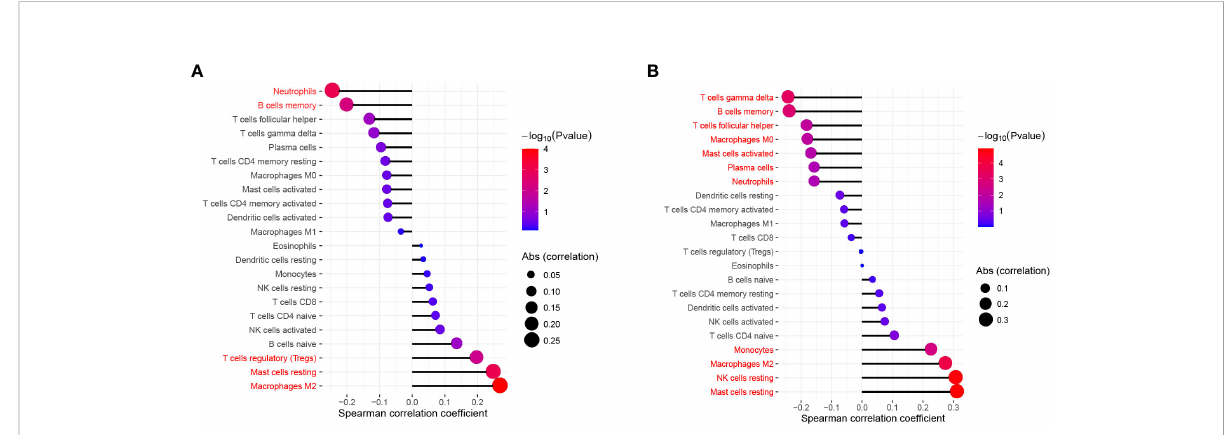
FIGURE 2 The relationship between FEV1 post-bronchodilator % predicted (A) , DLCO (B) and the in fi ltration level of lung tissue-in fi ltrating immune cells; Statistical signi fi cance (P<0.05) in red font.